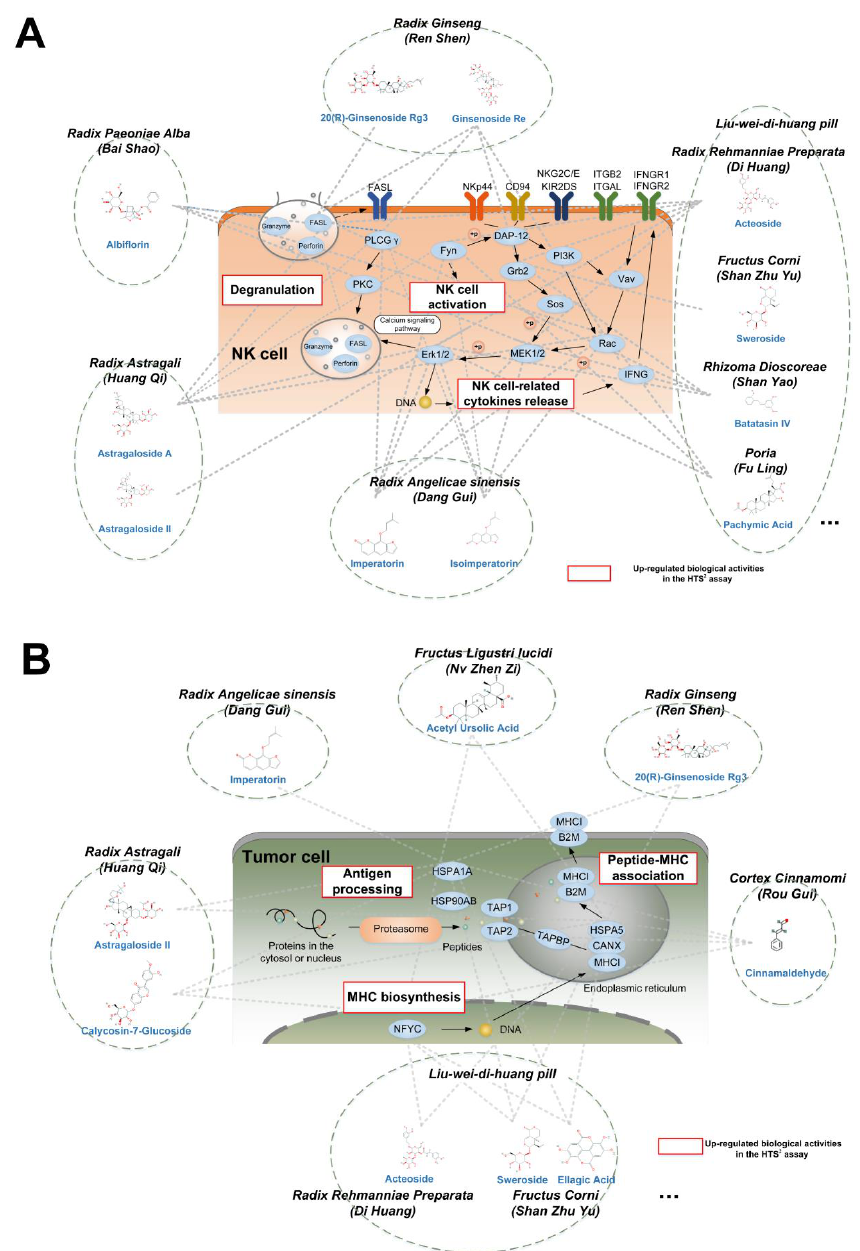
Figure 3. The regulatory effects on immune-related pathways induced by a group of compounds from health-strengthening herbs. The dotted lines linked the TCM compounds and the DEGs after compound treatment in the HTS 2 assay. ( A ) The HTS 2 assay results showed that compounds from health strengthening herbs upregulated the biomolecules in the NK cell mediated cytotoxic pathway. ( B ) The HTS 2 assay results showed that compounds from health strengthening herbs upregulated the biomolecules involved in the MHC-I antigen processing and presentation